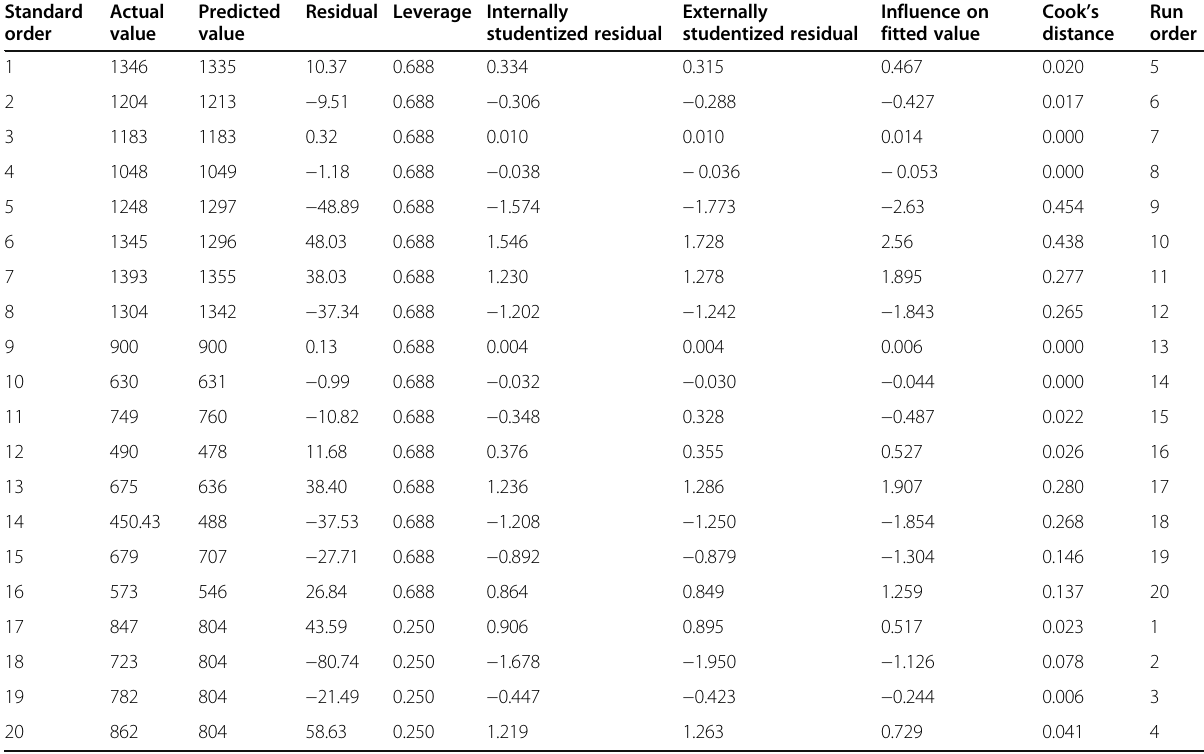
Table 9 Diagnostics case statistics report of observed and predicted TPH Standard